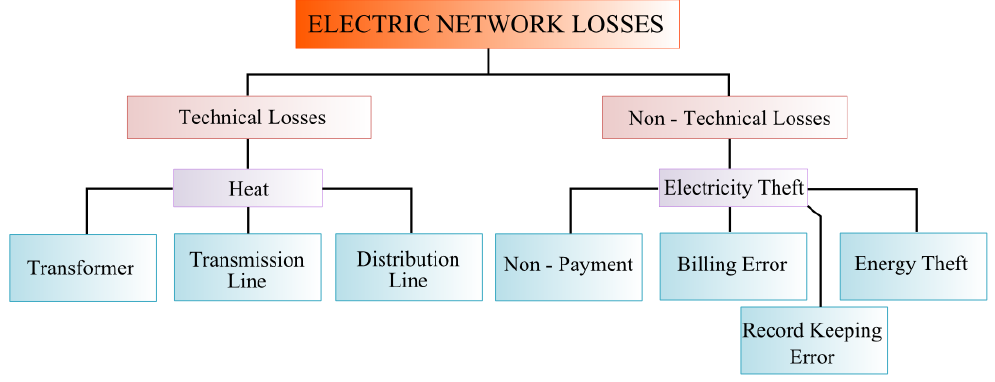
Figure 1. Power losses qualification in electric network.